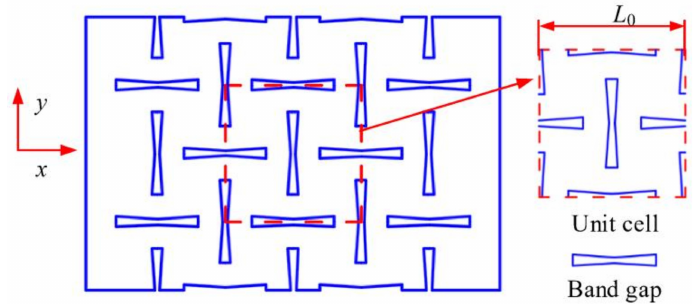
Figure 3. Periodic arrangement of cell